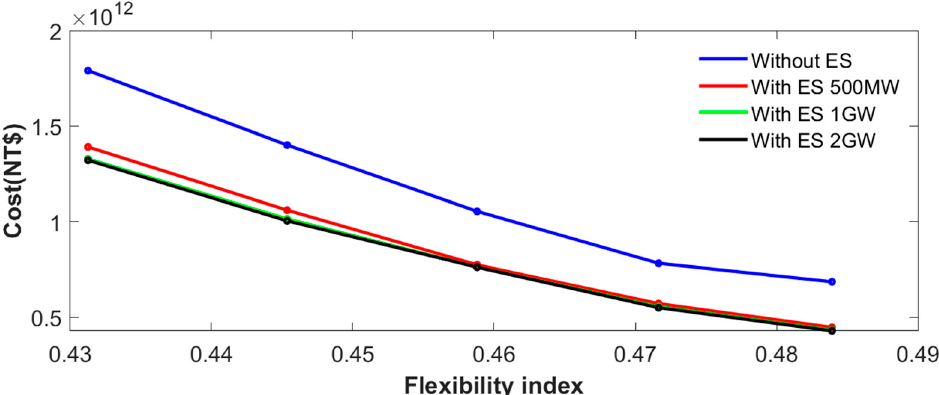
Figure 8. Relationship between multi-scenario unit scheduling cost and generation flexibility in spring.